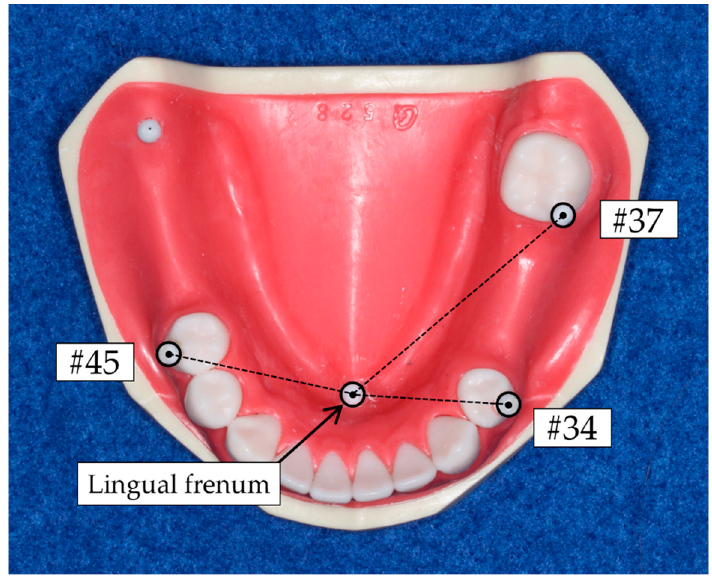
Figure 3. Distance between the central coordinate of the stainless-steel spherule placed on the lingual frenum and that on the buccal cusp of each target tooth was evaluated for the linear accuracy analysis.